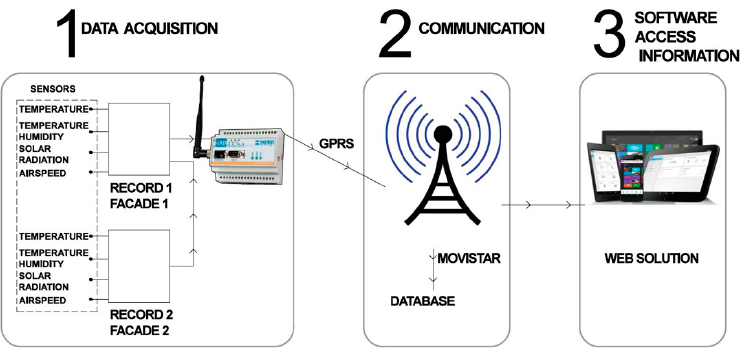
Figure 5. Connection flow chart.